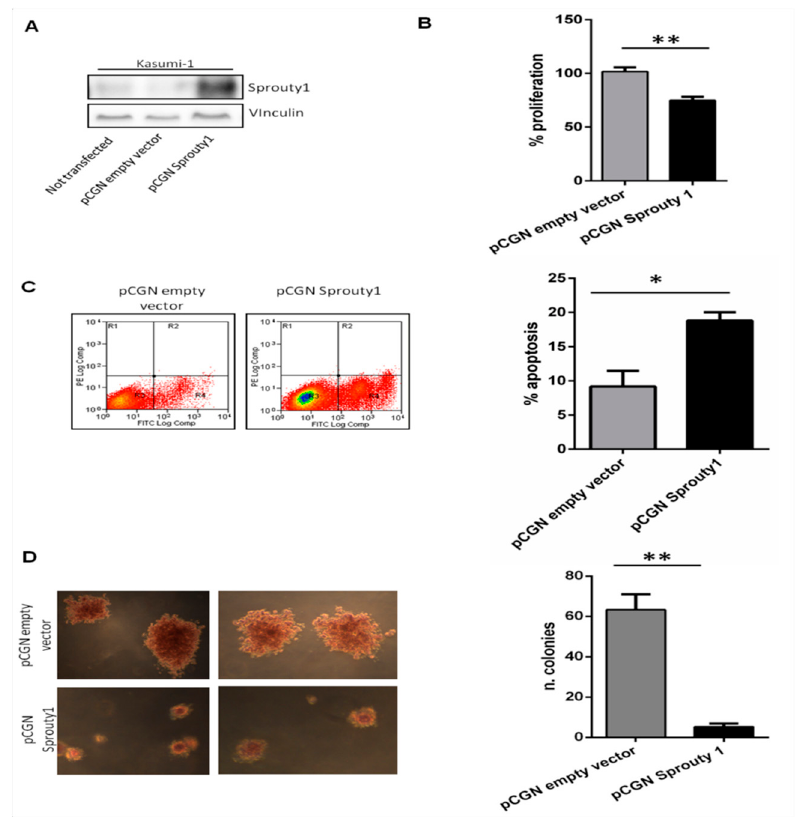
Figure 2. ( A ) Western blot analysis and quantification performed on Kasumi-1 cell lines